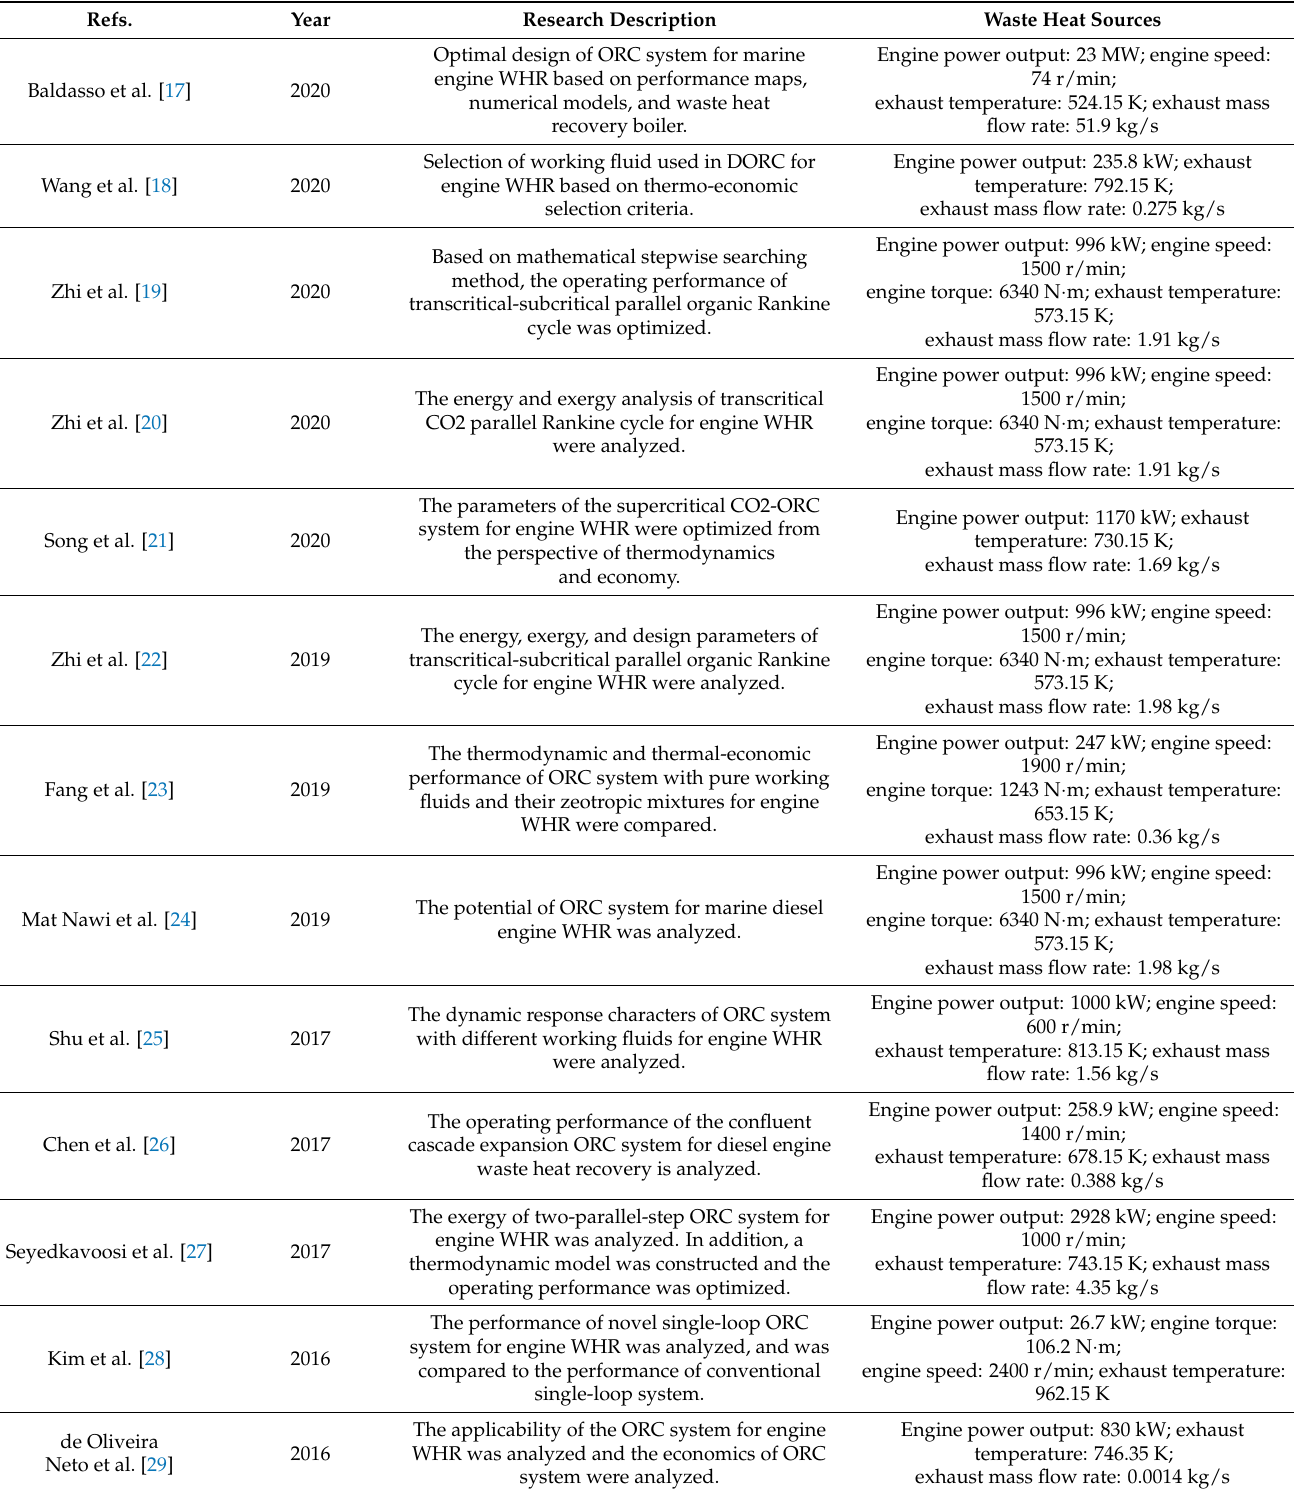
Table 1. Selection of operating conditions of IC engine.